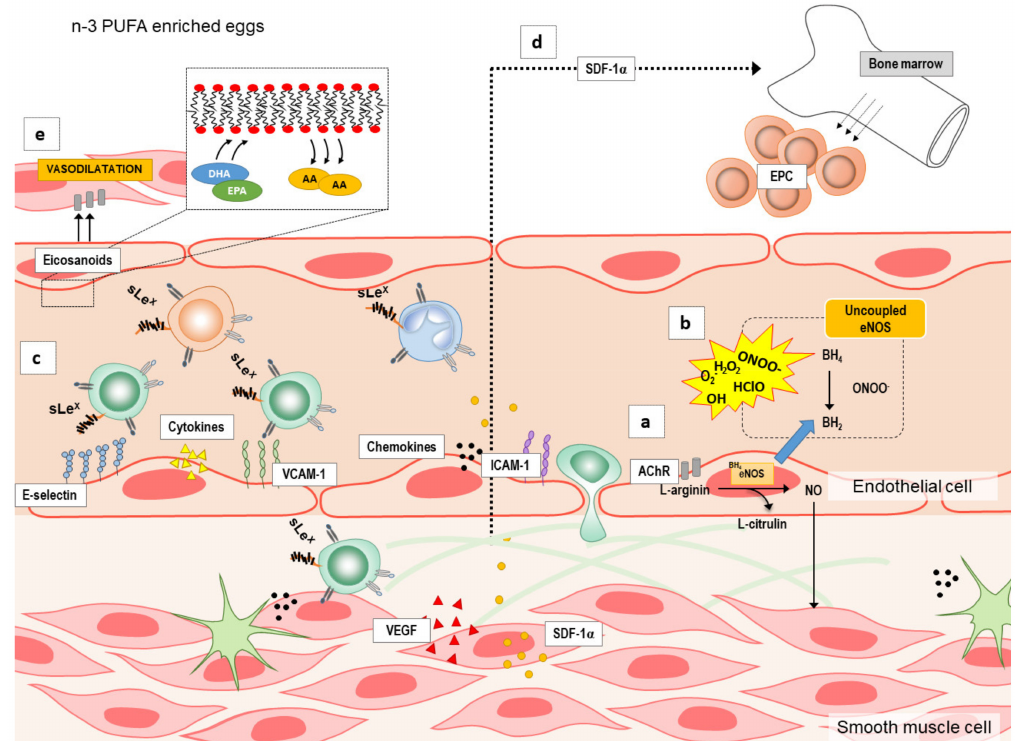
Figure 1. The summary of the potential mechanisms by which n-3 polyunsaturated fatty acids (n-3 PUFAs) supplementation may modulate endothelial function. Several possible targets by which n-3 PUFAs supplementation modulate endothelial function are: ( a ) increasing production of endothelium nitric oxide (NO), ( b ) reducing formation or increasing elimination of reactive oxygen species (ROS), ( c ) decreasing vascular or systemic inflammation (e.g., endothelial activation and endothelium–leukocyte interaction), ( d ) inducing angiogenesis / neovascularization and mobilization of bone-marrow derived endothelial progenitor cells (EPCs), and ( e ) increasing the expression and / or activity of other endothelium-derived vasodilators (e.g.,